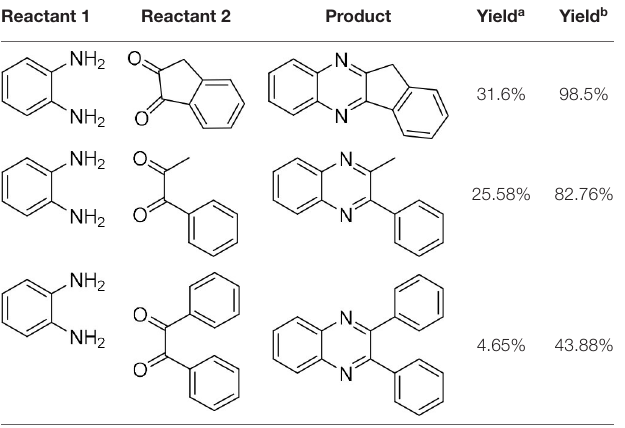
TABLE 1 | Synthesis of various quinoxalines in microdroplets and bulk solution. Reactant